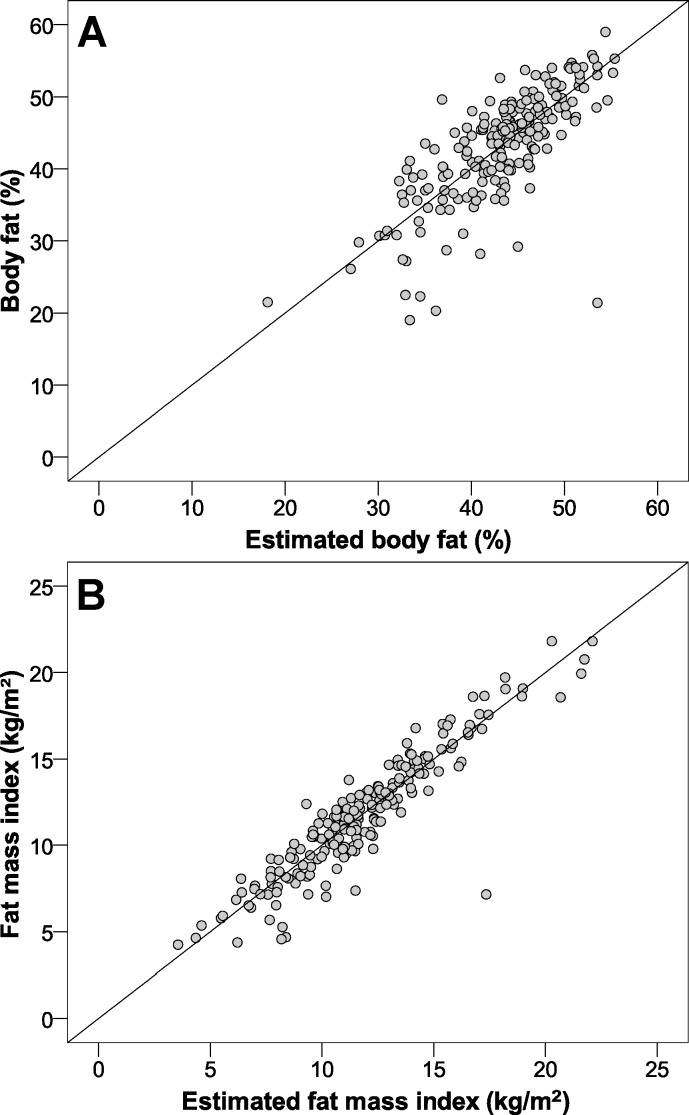
Scatter plot to show the adjustment between the proposed formulas (estimations) and the real parameters in the validation sample.(A) body fat; (B) fat mass index.